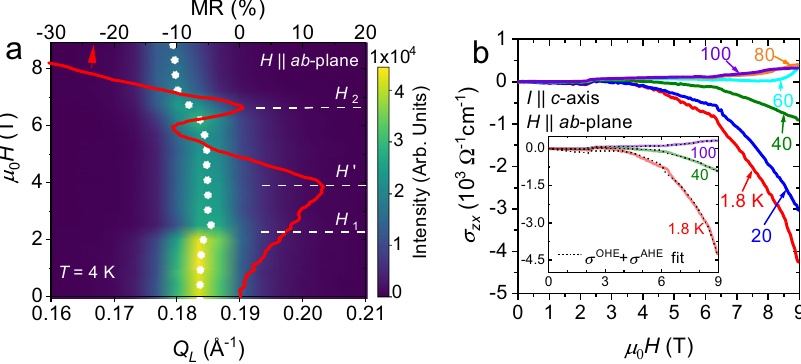
Fig. 3 Magnetotransport and small angle neutron scattering intensity of YMn 6 Sn 6 . a Neutron intensity-Q map of the magnetic fi eld dependence of the magnetic Bragg peak observed in small angle neutron scattering, adapted from Ghimire, et al. 10, 20 , plotted together with the magnetoresistance (MR) for current along the c -axis. Q L refers to the z -component of the scattering vector, Q. In both cases, magnetic fi eld is applied in the ab -plane. The white dots are a guide to the peak center. White dashed lines locate the magnetic structure transitions indicated by H 1 and H 2 and the MR turnover at H 0 . b Hall conductivity, σ zx , as a function of magnetic fi eld, H , at indicated temperatures. Inset depicts the fi ts (black dotted lines) of the Hall conductivity comprised of only ordinary, σ OHE ¼ R H H ρ (cid:2) 1 zz ρ (cid:2) 1 xx , and anomalous, σ AHE = S H M , conductivity contributions, where R H is the ordinary Hall coef fi cient, and S H is the anomalous Hall coef fi cient, M is the magnetization vs fi eld applied in the ab -plane, and ρ zz and ρ xx are the longitudinal resistivities for current applied along the c -axis and current applied in the ab -plane,